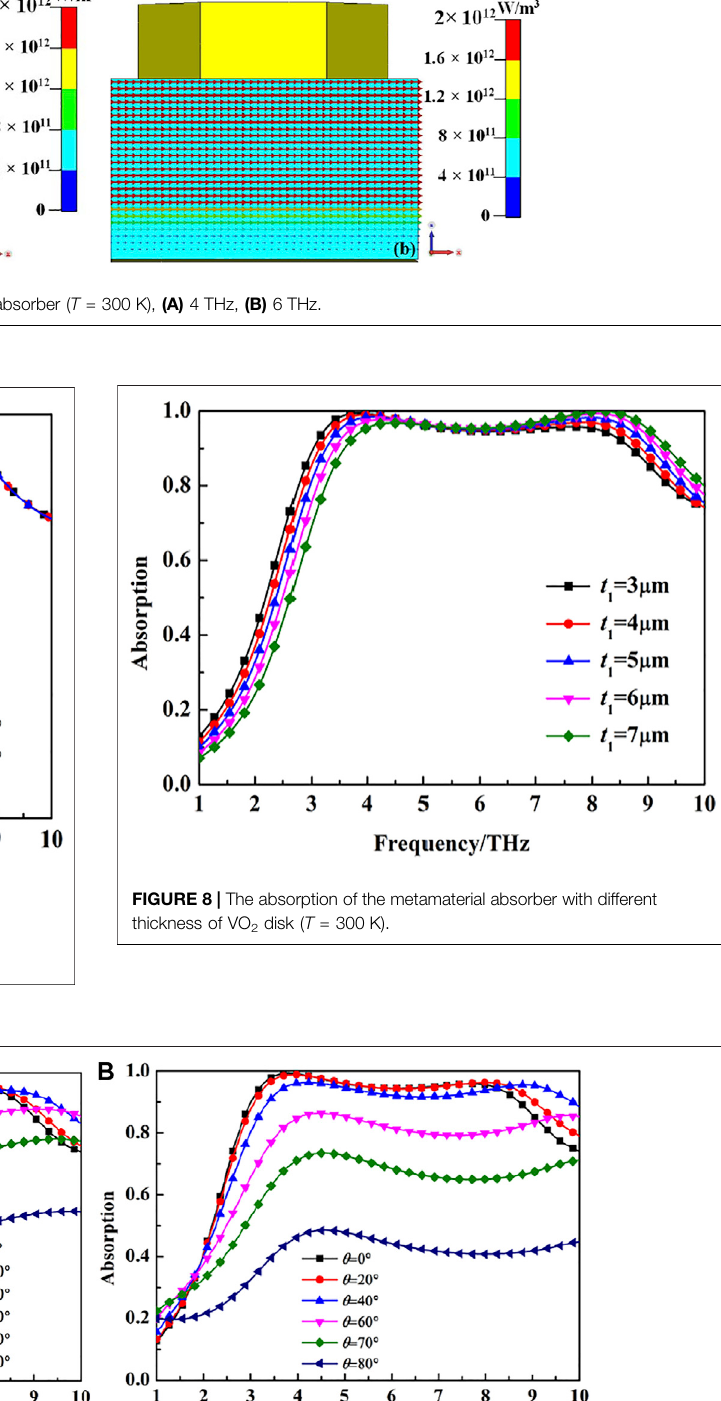
Frontiers in Materials |